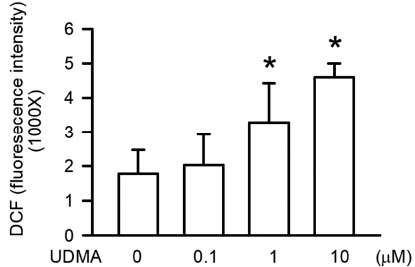
Figure 7. UDMA induced intracellular ROS generation in RAW264.7 macrophages. Data are expressed as mean ± SD (n = 5). * P < 0.05 is considered significant compared with control